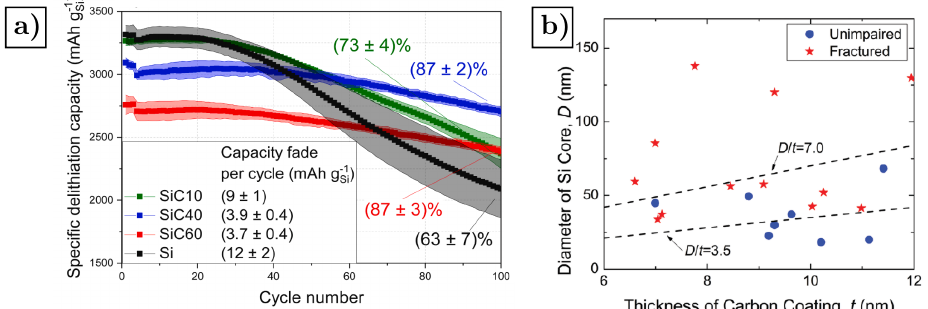
Figure 9. Effect of carbon coating on capacity fade. ( a ) Specific delithiation capacity as a function of the number of cycles for silicon thin film with carbon coating of different thickness, namely 10 nm, 40 nm, and 80 nm, for SiC10, SiC40 and SiC80, respectively. Reprinted with permission by Elsevier from [64], Copyright 2021. ( b ) Occurrence of fracture as a function of the ratio between particle diameter ( D ) and coating thickness ( t ). Reprinted with permission by Royal Society of Chemistry from [65], Copyright